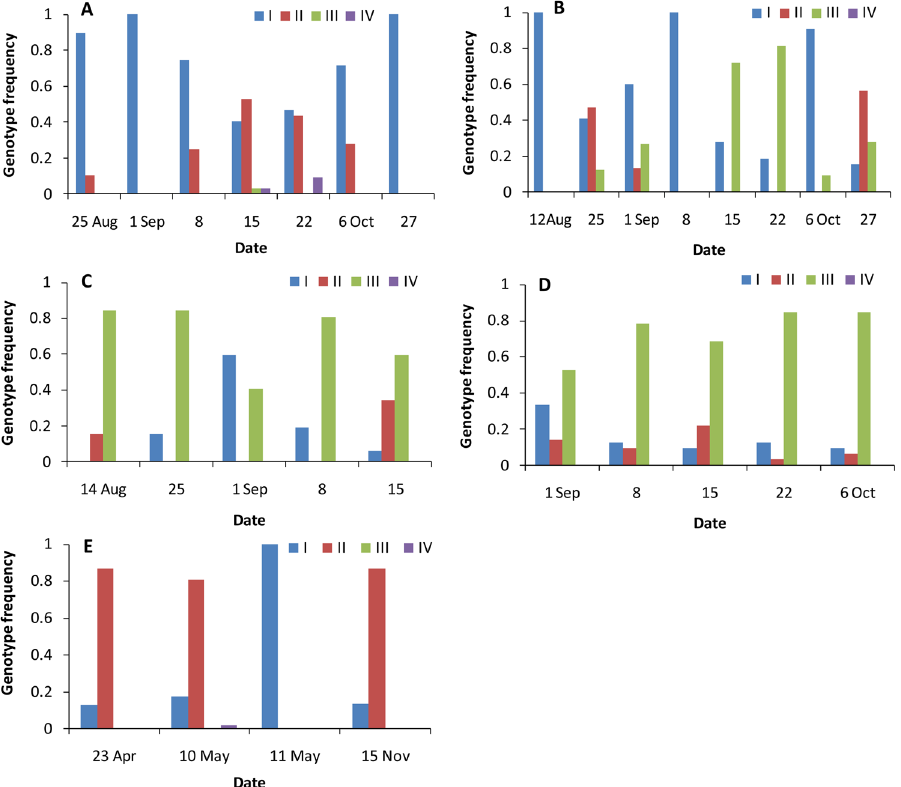
Figure 6. Genotype frequencies of Aphis gossypii on cotton ( A ), zucchini ( B ), cucumber ( C ), pumpkin ( D ) and hibiscus ( E ) on different survey dates in